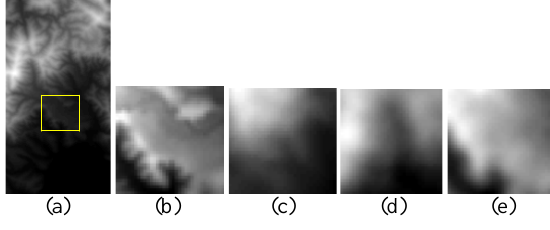
Figure 4. (a) LiDAR DEM and marked template; (b) LiDAR template; (c) and (d) Erroneous patches found incorrectly by the CCF and MI; and (e) Correct DEM window found via GMI.